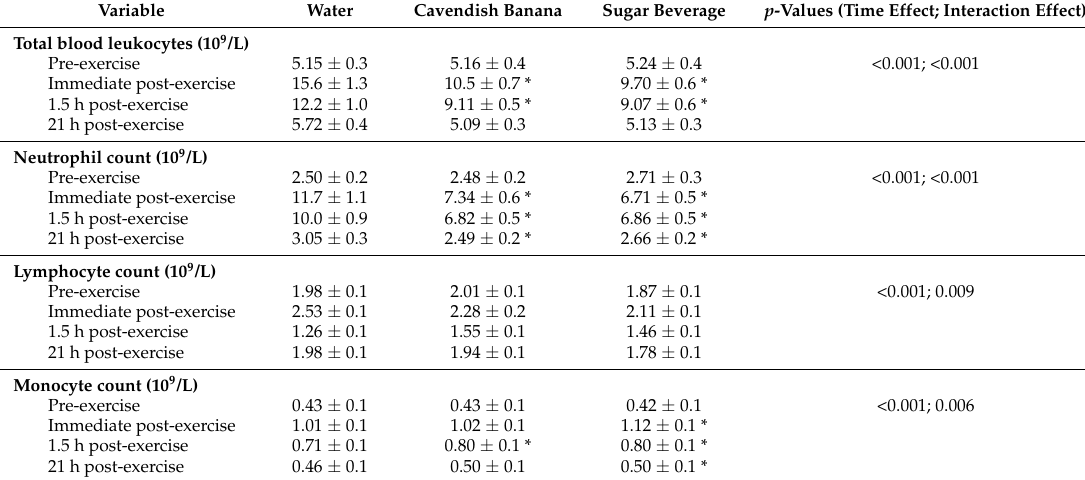
Table 1. Change in leukocyte subset counts following 75 km cycling in n = 20 cyclists (immediately, 1.5 h, and 21 h